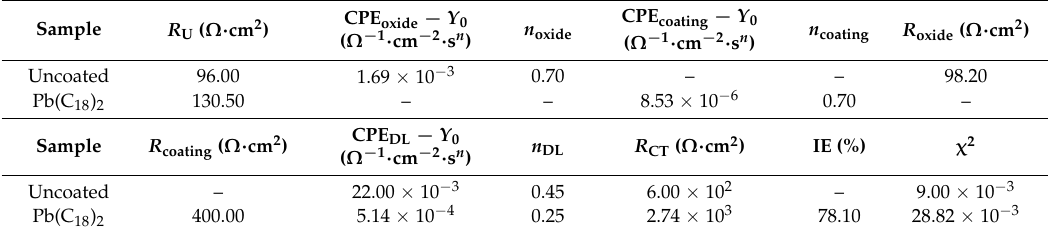
Table 1. The important EIS fitting parameters in a 0.1 M TBAB solution containing 5 µ g · L − 1 acetic acid of lead coupons immersed in 50 mM NaC 18 solution for 24